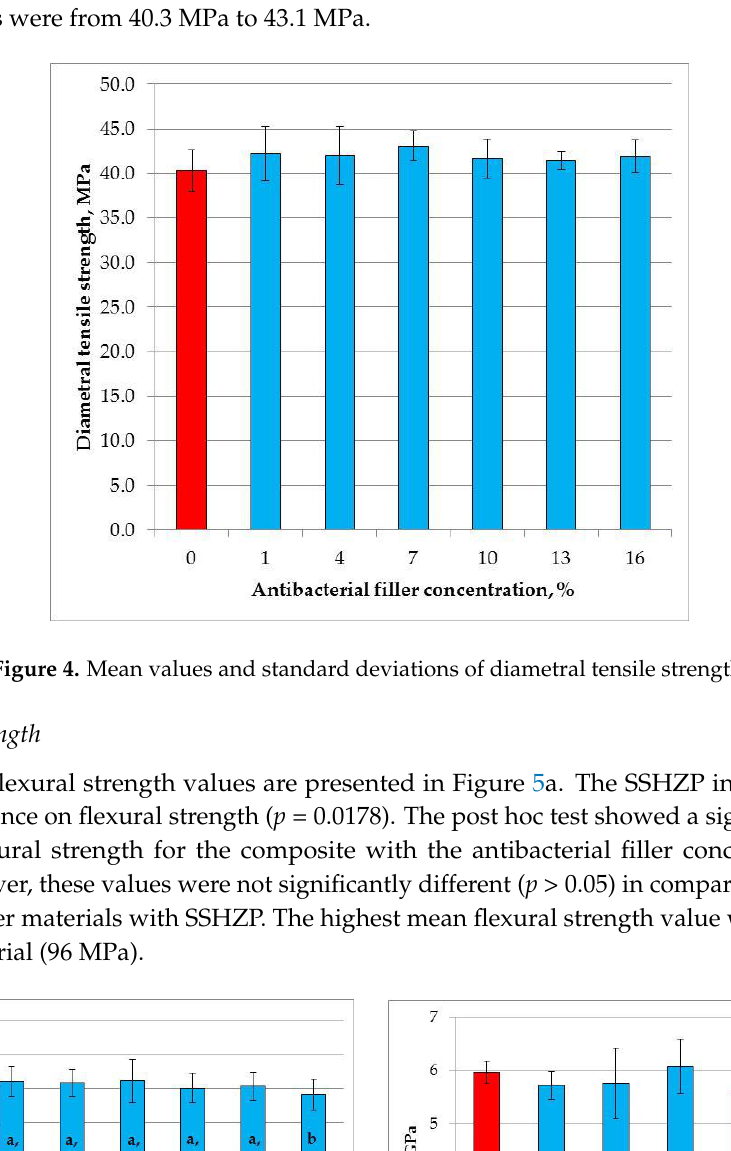
Figure 4. Mean values and standard deviations of diametral tensile strength.